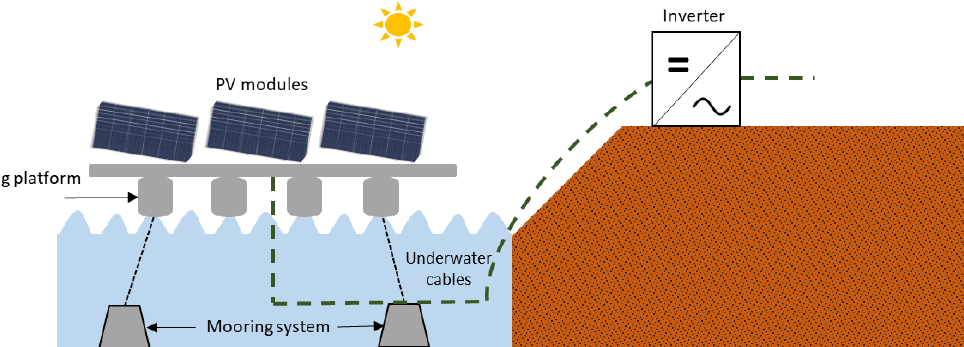
Figure 14. Schematic diagram of a floating photovoltaic power plant.